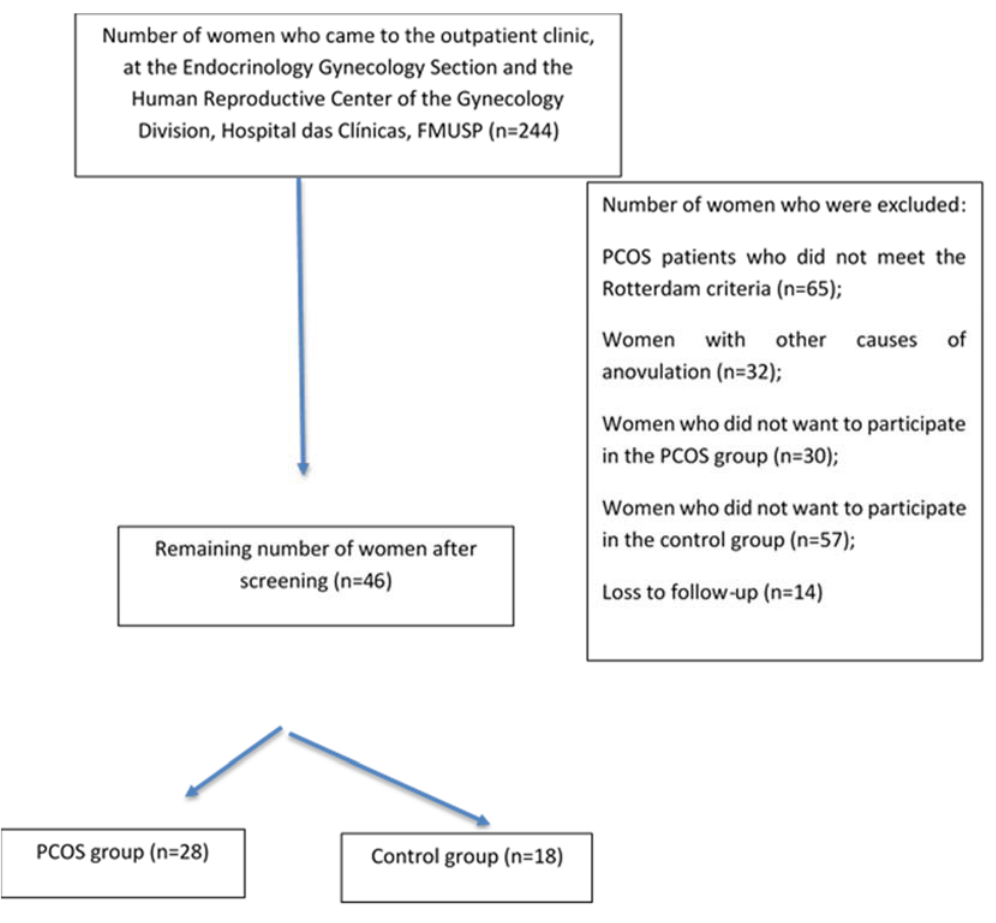
Figure 1. Flow chart of the study .